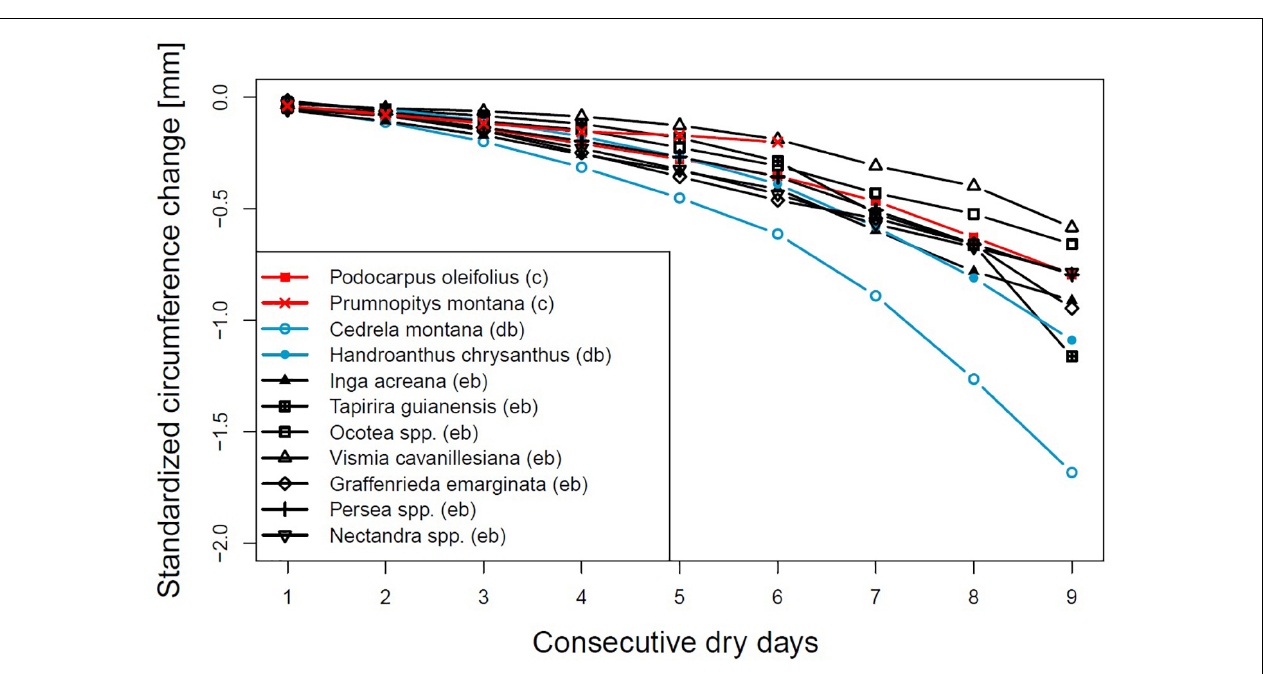
were not instrumented during the second measurement period from March 2015 to December 2017. In Table 2 , correlations between daily stem